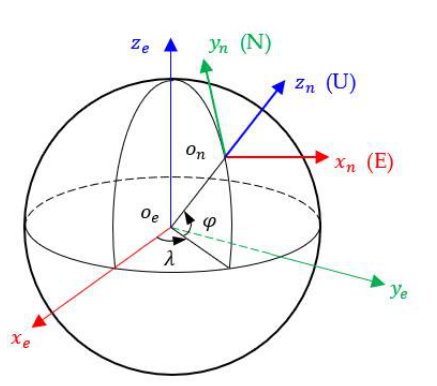
Figure 4. Relationship between the Earth-centered-Earth-fixed (ECEF) frame and the east-north-up (ENU) frame, with letters distinguished with subscripts e and n , respectively.